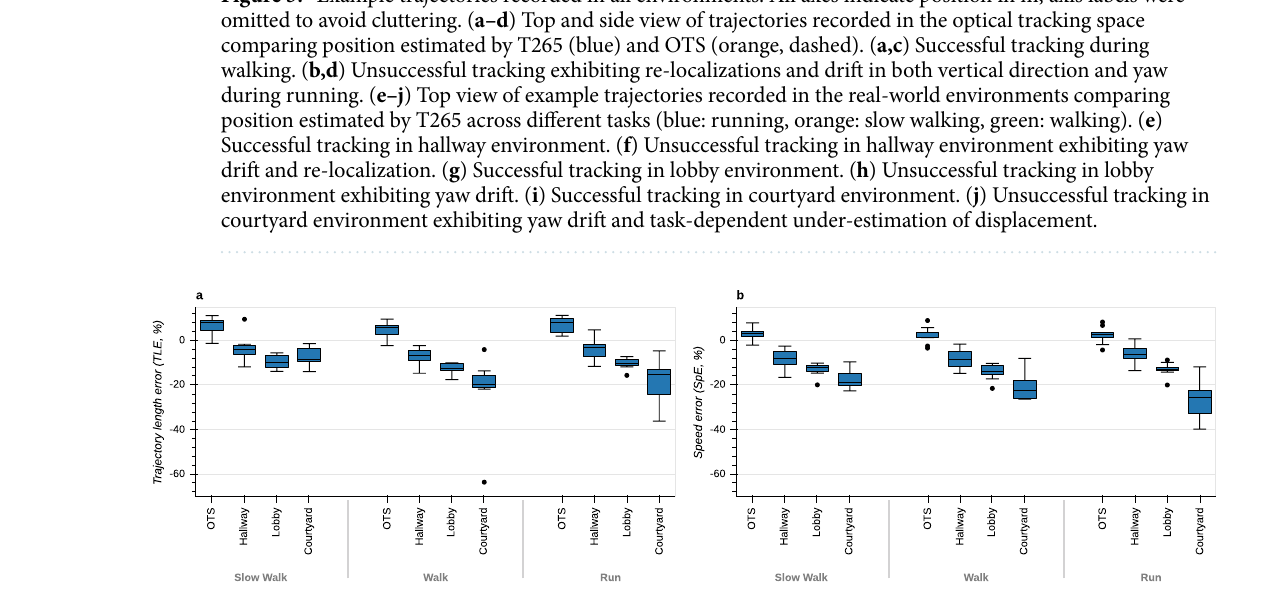
Figure 4. Boxplots of trajectory length and speed errors between T265 and gold standard across different environments and tasks. ( a ) Trajectory length errors. ( b ) Speed 0.013 ) and running ( p 0.005 ) compared to walking. TLE in the perambulator study are slow walking ( p = = 10.08, p 0.002 ) and task ( F ( 2, 14 ) 7.75, p 0.005 ). Median values dependent on environment ( F ( 2, 14 ) = = = = are negative and under-estimation is significantly smaller in the hallway environment when compared with the 0.013 ) and courtyard environments ( p 0.015 ). Additionally, we observe more under-estimation lobby ( p = = 0.012 ) and walking ( p 0.007 ) compared to slow walking. during running ( p = = Positional data was also used to quantify absolute and relative translation error (ATEs, RTEs) and yaw error (AYEs, RYEs) as well as drift in translation (TDrs) and yaw (YDrs, Fig. 5). Median absolute translation 1.77, p 0.202 , Fig. 5a). RTE are errors (ATEs) are around 0.4 m and values do not depend on task ( F ( 2, 16 ) = = 26.57, p < 0.001 ) and significantly higher in the running task than in the walking dependent on task ( F ( 2, 16 ) = 0.002 ) and slow walking task ( p < 0.001 , Fig. 5b). Median translation drifts (TDrs) are between 0.2 and 0.4 ( p = 2.35, p 0.128 , Fig. 5c). Median Median absolute yaw errors m/h and values are not task-dependent ( F ( 2, 16 ) = =